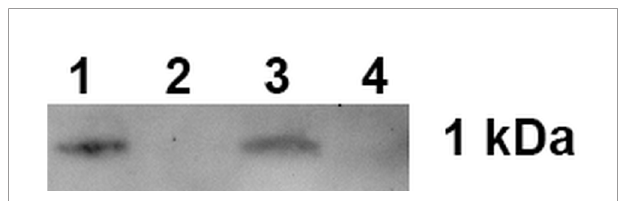
FIGURE 1 | Peptide 17.1A binding to sTNFRI immobilized on CN-Br-sepharose. 1 – control 17.1A, 2 – column washing before the elution, 3 – elution of the sTNFR1-bound material, 4 – peptide 17.0 elution from the column.